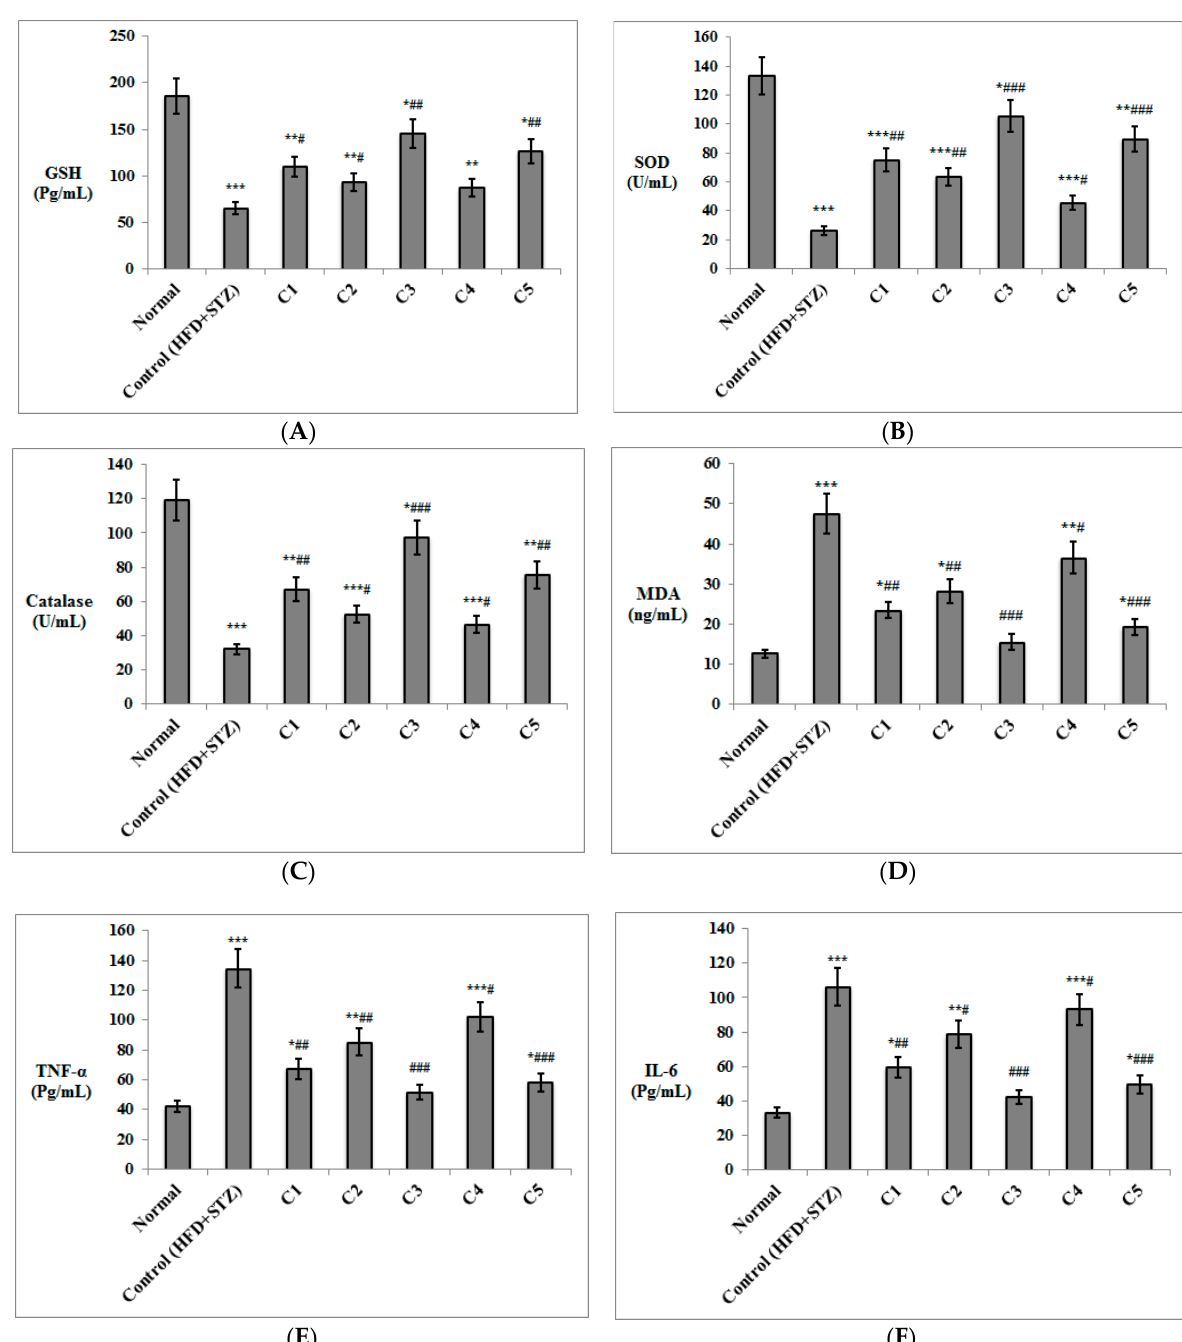
Figure 2. Antioxidant and anti-inflammatory effects of the isolated compounds on erythrocyte lysate levels of ( A ) GSH, ( B ) SOD enzyme, ( C ) catalase enzyme, as well as serum levels of ( D ) MDA, ( E ) TNF- α , and ( F ) IL-6. ( n = 6–8). GSH = reduced glutathione; SOD = superoxide dismutase; MDA = malondialdehyde; TNF- α = tumor necrosis factor-alpha; IL-6 = interleukin-6. Levels of MDA, TNF- α and IL-6 were determined in serum, whereas concentrations of GSH, SOD and catalase were estimated in the erythrocyte lysate. C1: Rutin; C2: Quercetin 3- O -neohesperdoside; C3: Quercetin-3- O - β -galactoside; C4: Isoquercetin; C5: Quercetin. Data are expressed as mean ± SD and analyzed. Statistical significance in relation to the normal group was assigned at * p < 0.05; ** p < 0.01; and *** p < 0.001; whereas statistical significance in relation to the T2DM control group (high fat diet + Streptozotocin) was assigned at # p < 0.05; ## p < 0.01; and ### p < 0.001 using one-way ANOVA followed by Bonferroni’s post hoc test.